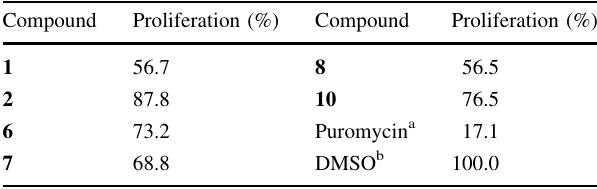
Table 1 NSCs Proliferation of Compounds 1 – 2 , 6 – 8 , and 10